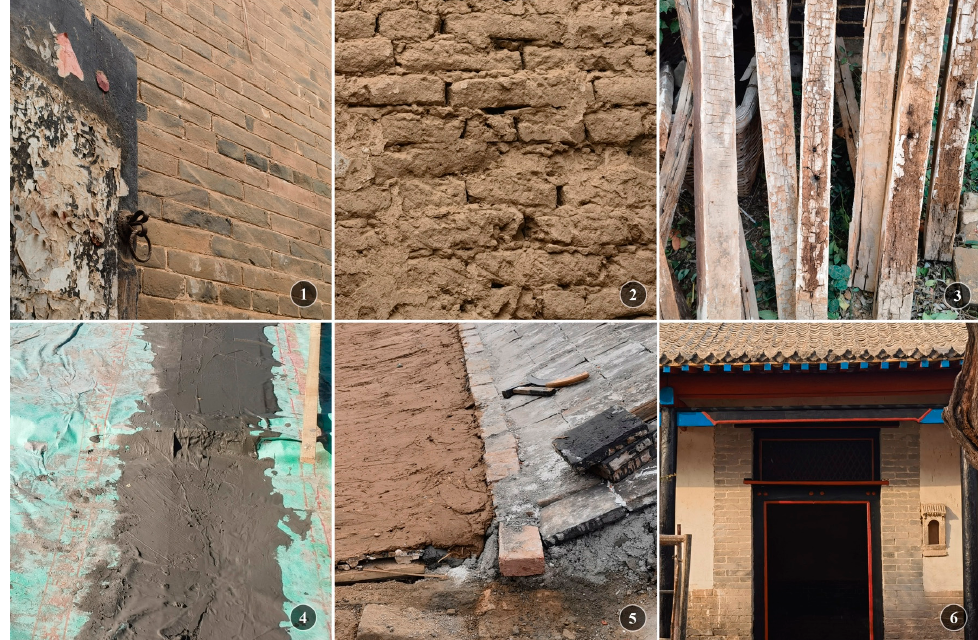
Figure 12. Materials for courtyard-style Confucian architecture: 1—green bricks, 2—wall blanks, 3—Larchwood, 4—JS waterproof layer, 5—thatched back (ShanBei), 6—painted finishes. Photo by W. Rong.